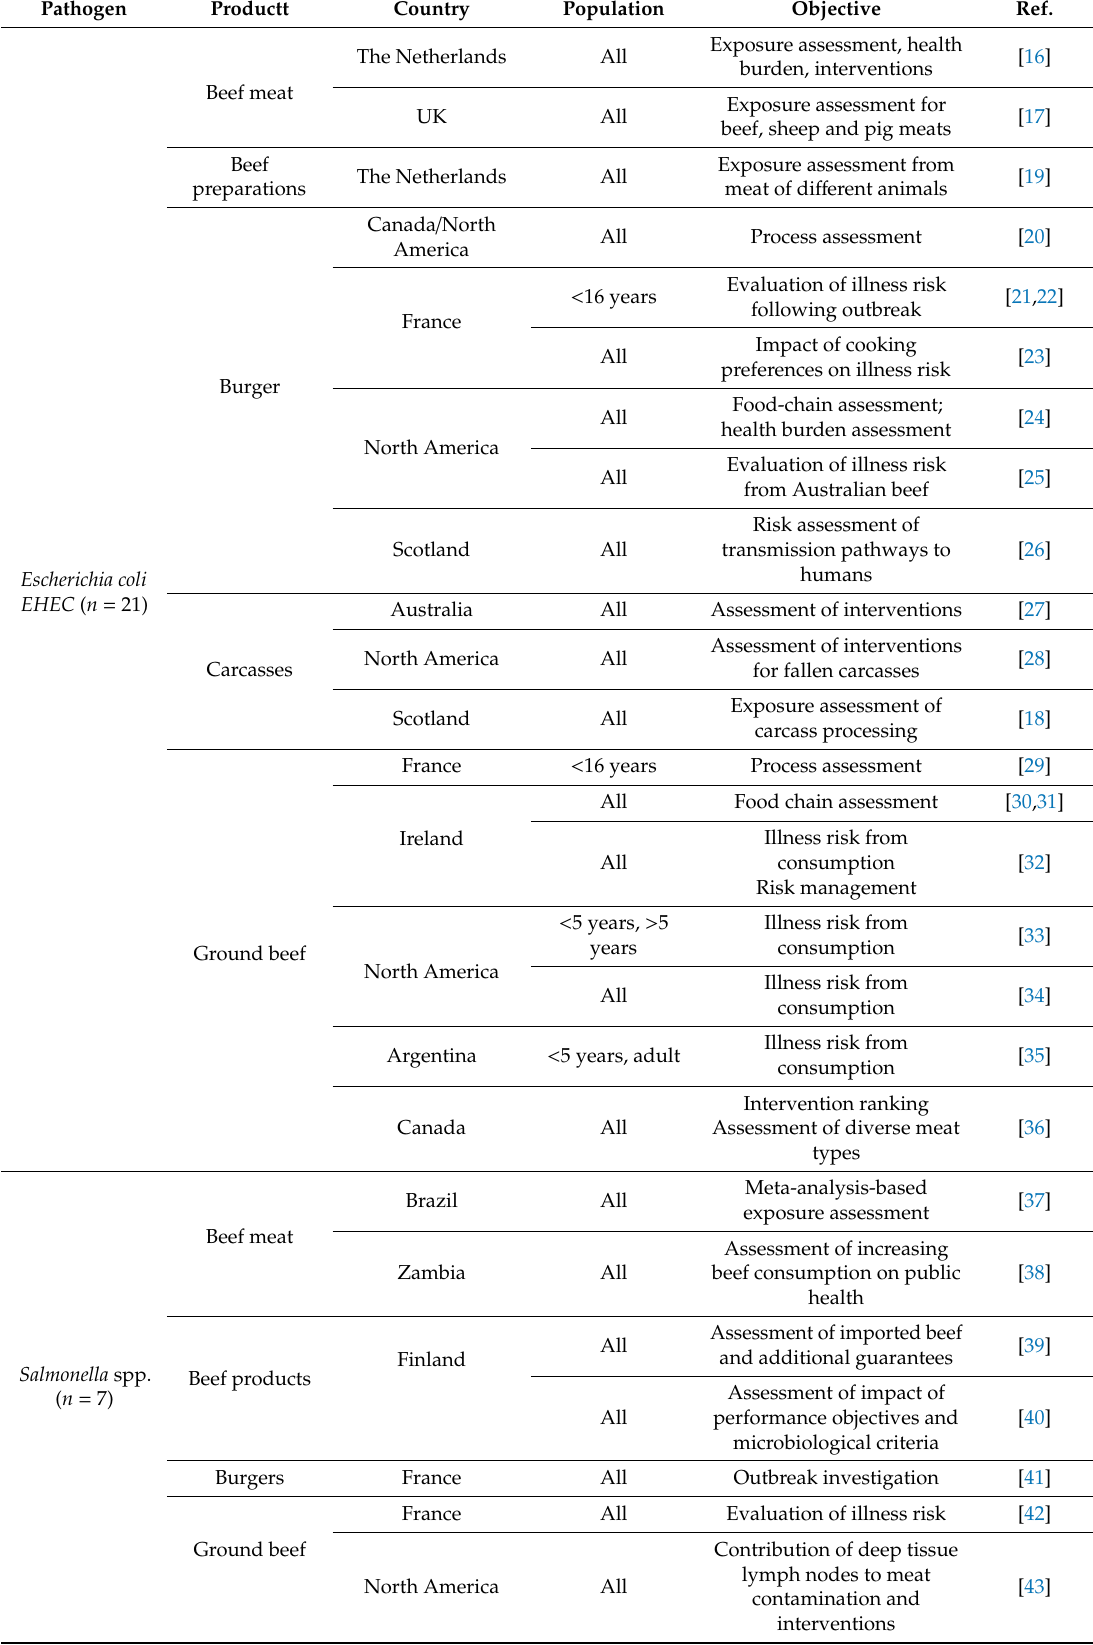
Table 1. Summary of beef quantitative microbial risk assessment (QMRA) models collected.